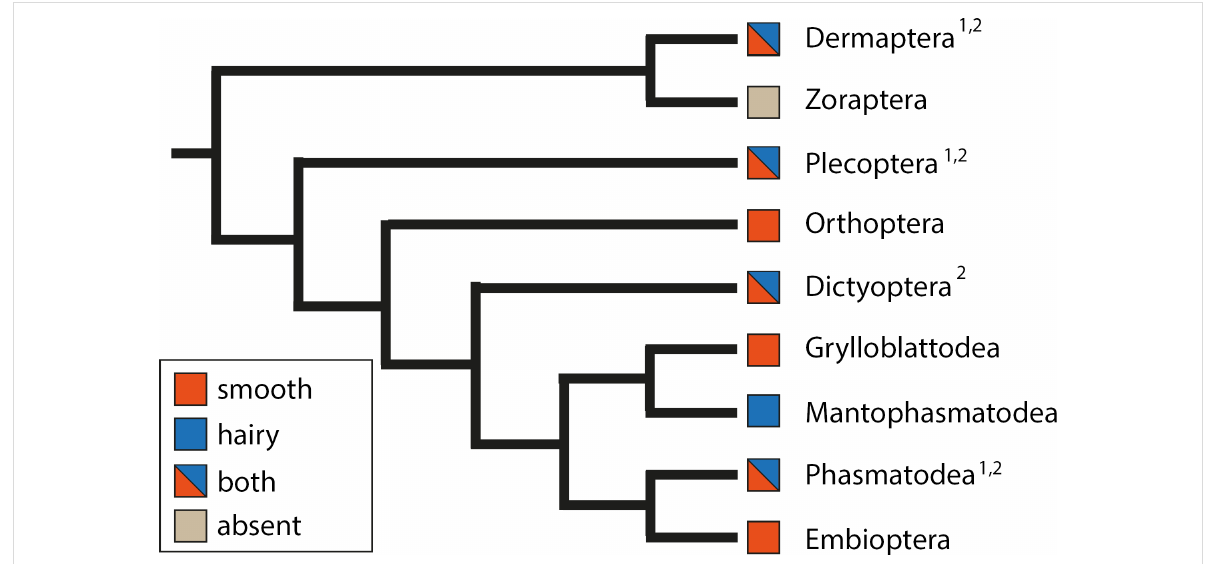
Figure 3: Phylogeny of Polyneoptera (following [122]). Coloured squares indicate the type of attachment pads, 1 different pad types on the same tarsus, and 2 in different species.